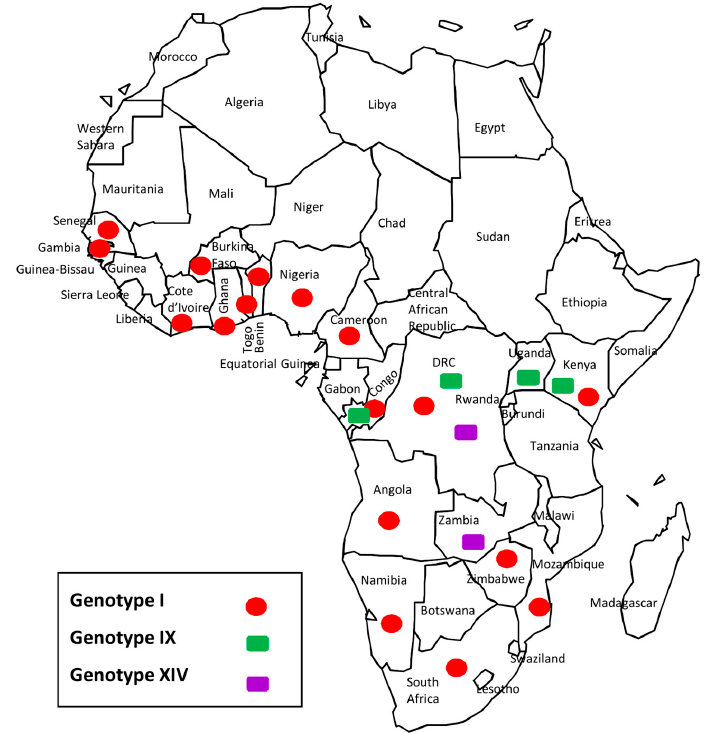
Figure 5. Continental distribution of the three p72 genotypes revealed by this study in the DRC. Position of symbols represents the presence of a genotype within the country, and is not indicative of specific geographic localities.